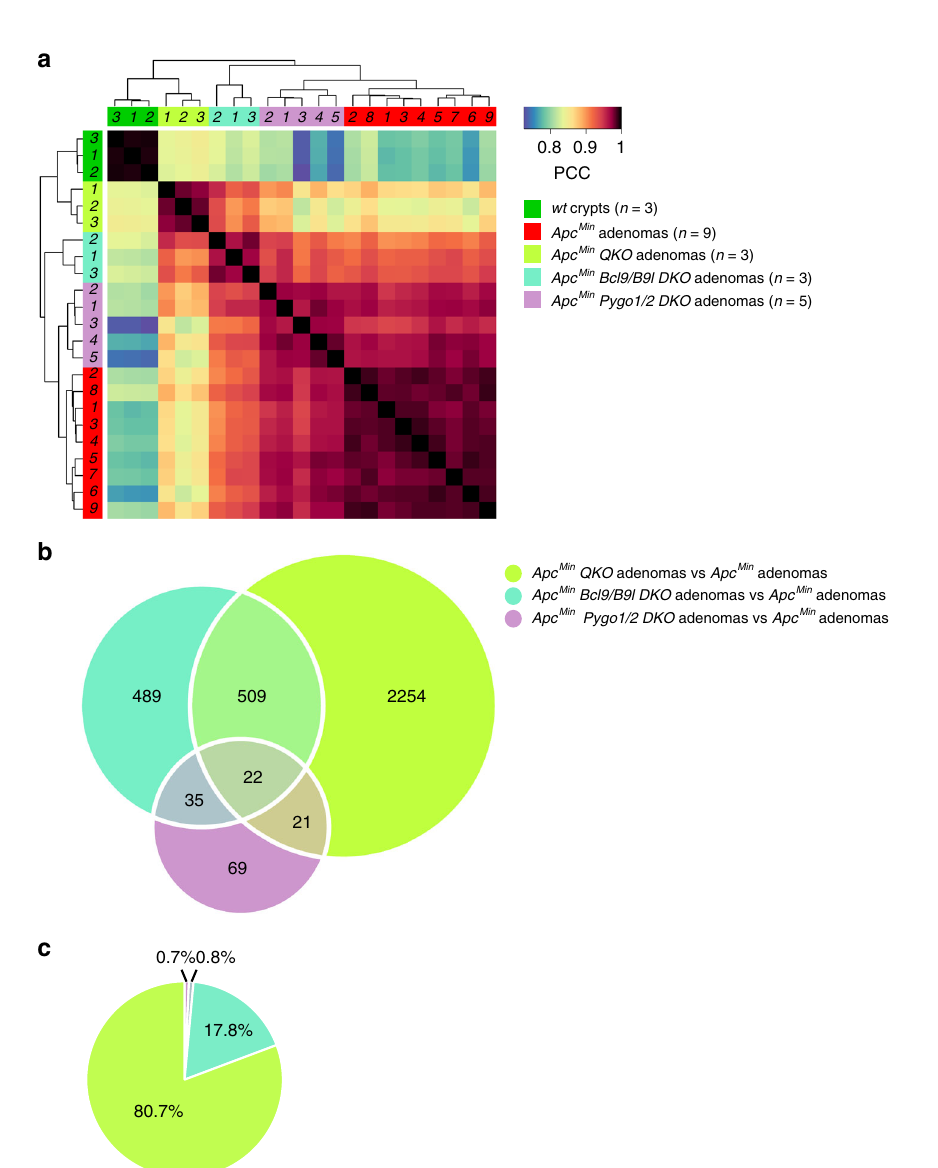
Fig. 2 Simultaneous Bcl9 and Pygo loss normalises the Apc -mutant gene expression pro fi le of adenomas. a Volcano plot showing gene probe changes between Apc Min adenomas vs normal crypts; coloured , set of gene probes showing the strongest trend reversals between QKO and control adenomas, as shown in ( b ); labeled are selected Wnt target ( right ) or Defensin genes ( left ), up- ( red ) or downregulated ( blue ) in adenomas vs normal crypts ( p < 0.01, Benjamini & Hochberg FDR); additional Wnt target genes were identi fi ed at a lower signi fi cance level ( p < 0.05, Benjamini & Hochberg FDR) including Ascl2 (slightly upregulated in adenomas, two independent probes) and Cdh1 (encoding E-cadherin; slightly downregulated in adenomas, one probe). b Heat map showing hierarchical clustering of 1800 gene probe changes ( p < 0.01, Benjamini & Hochberg FDR) across 5 different cohorts, colour-coded as indicated below; individual samples are designated by numbers in bar; shown are gene probes exhibiting the strongest reversals from adenoma to normal crypts in at least one of the three other cohorts; colours (coded as in a ) indicate Z-scores of normalised, VST- and batch-adjusted expression values for each individual gene probe. c Heat maps as in ( b ) for Wnt target and Defensin genes. See also Supplementary Figures 5 &